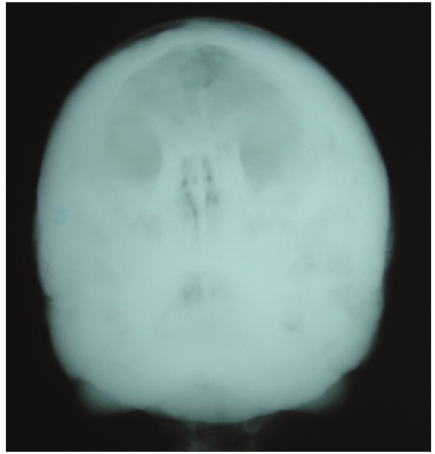
Figure 4: PNS view showing osteosclerosis and hypoplasia of sinuses and the nasal